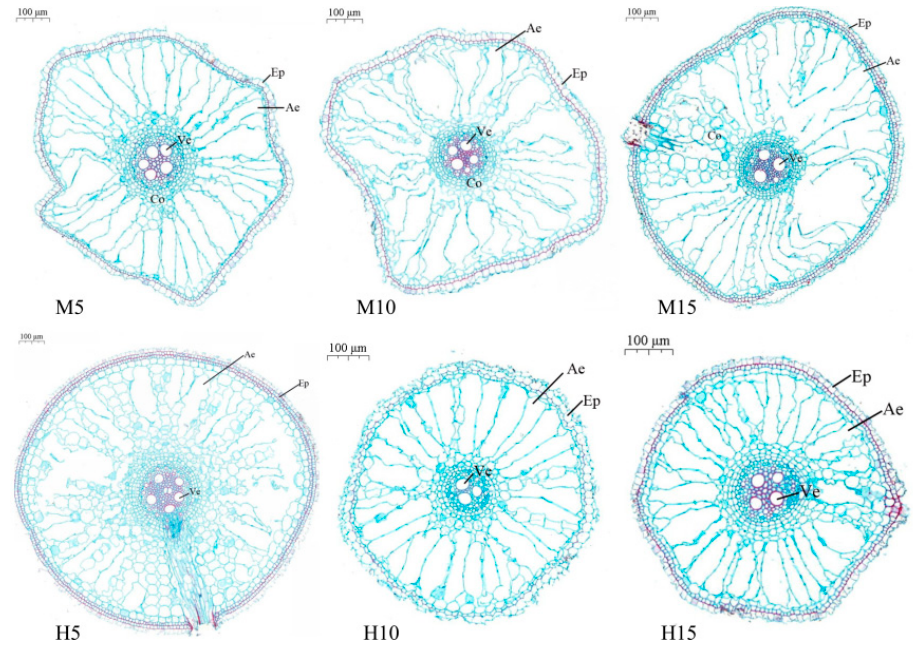
Figure 6. Cross-sectional map of root anatomy of rice at 20 days (29 August) after high temperature and waterlogging stress.